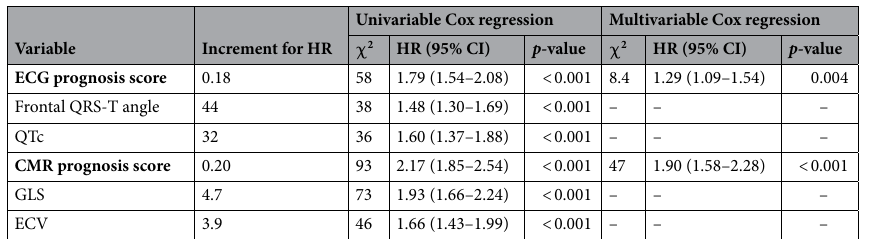
Table 2. Univariable and multivariable Cox regression for the ECG and CMR prognosis scores, as well as their respective components. The HR increment was 1 SD of the respective measure.